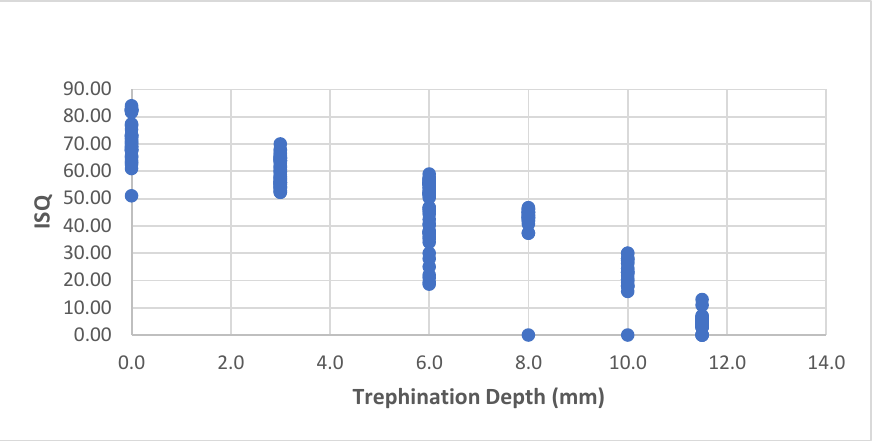
Figure 3. ISQ at each trephination depth in the united group. When considering the ISQ as a function of trephination depth (Figure 3), linear re- gression revealed a significant relationship between the trephination depth and the ISQ (F (1, 213) = 1113.192, p < 0.001, adjusted r2 = 0.839). The trephination depth significantly predicted the ISQ (β = −5.337, p < 0.001), and the ISQ decreased by −5.33 as the trephination depth increased by 1 mm. The predictive model was as follows : Implant stability = (initial ISQ) − 5.337 * (trephination depth). After controlling for the implant length, this correlation was still significant (r = −0.936, p < 0.001).